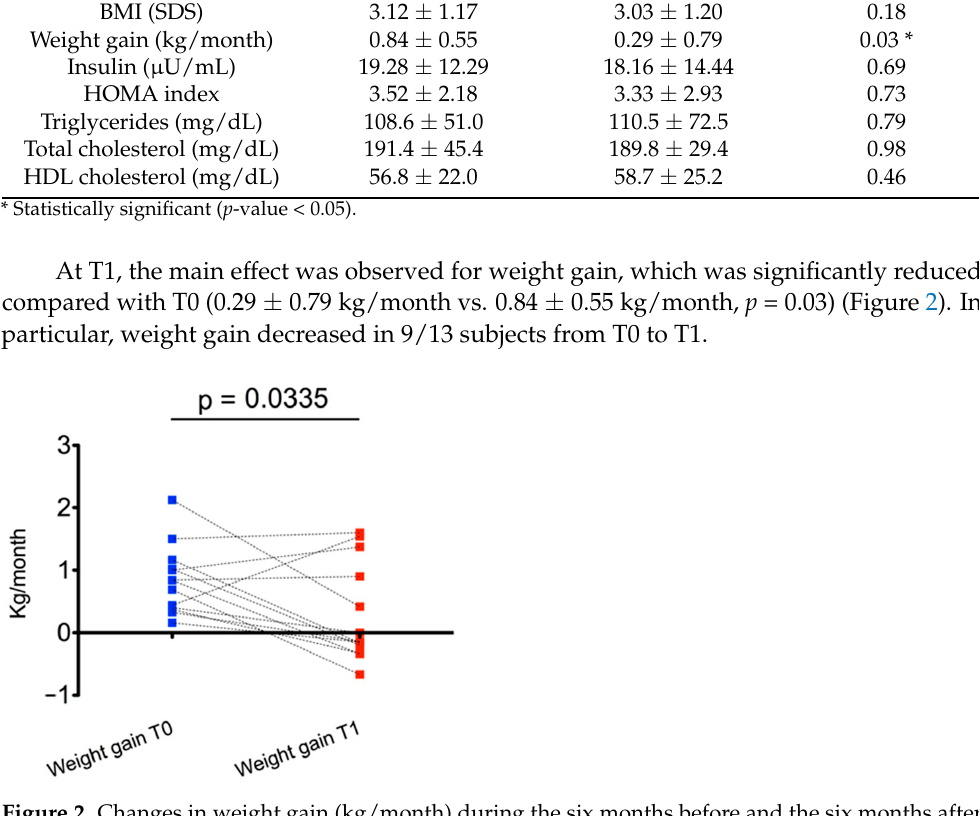
Table 3. Clinical and metabolic parameters at T0 and T1.